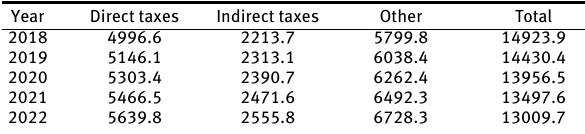
Table 3: Expected Miscellaneous